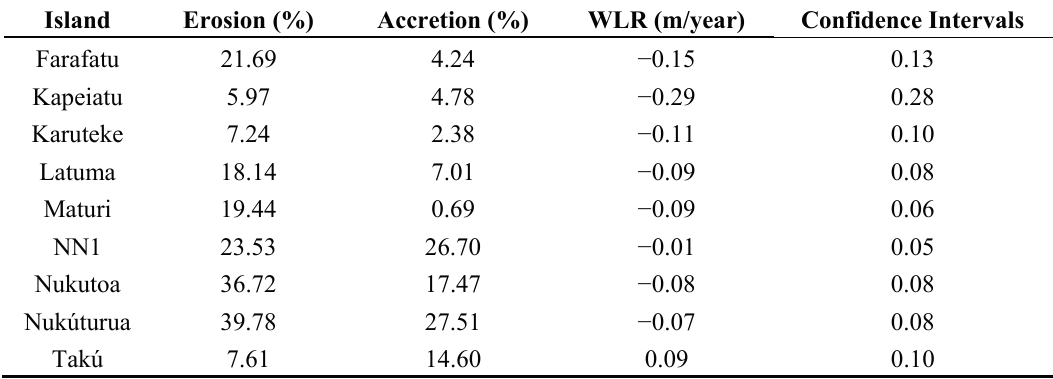
Table 4. Summary of weighted linear regression rates and its associated 2 σ confidence intervals and the percentage of transects showing statistically significant erosion and